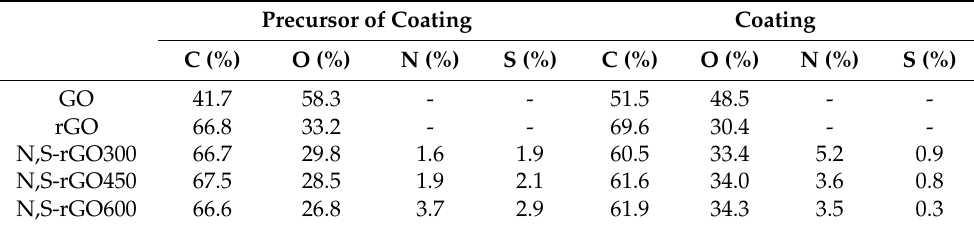
Figure 3. Raman spectra for precursors of coatings. Table 2. XPS estimate of the surface relative C, O, N and S content of the precursors of coatings and